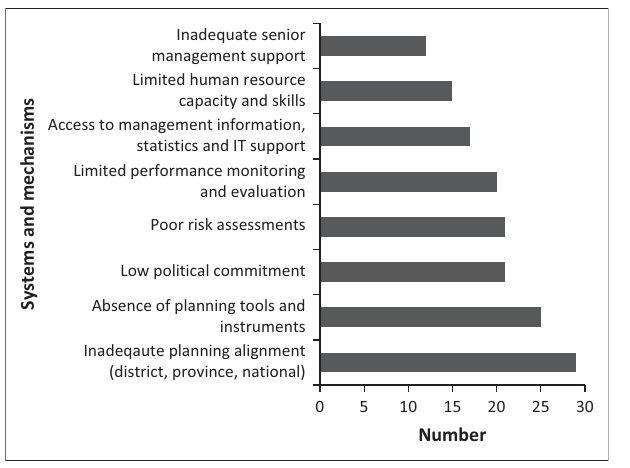
FIGURE 2: Absence of planning support systems and mechanisms detrimental to the integrated development plans